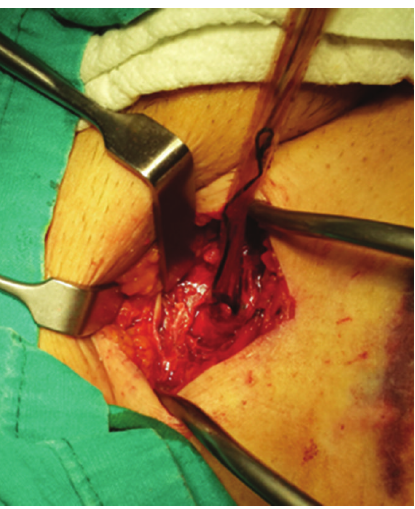
Figure 1: View of the retained balloon catheter.